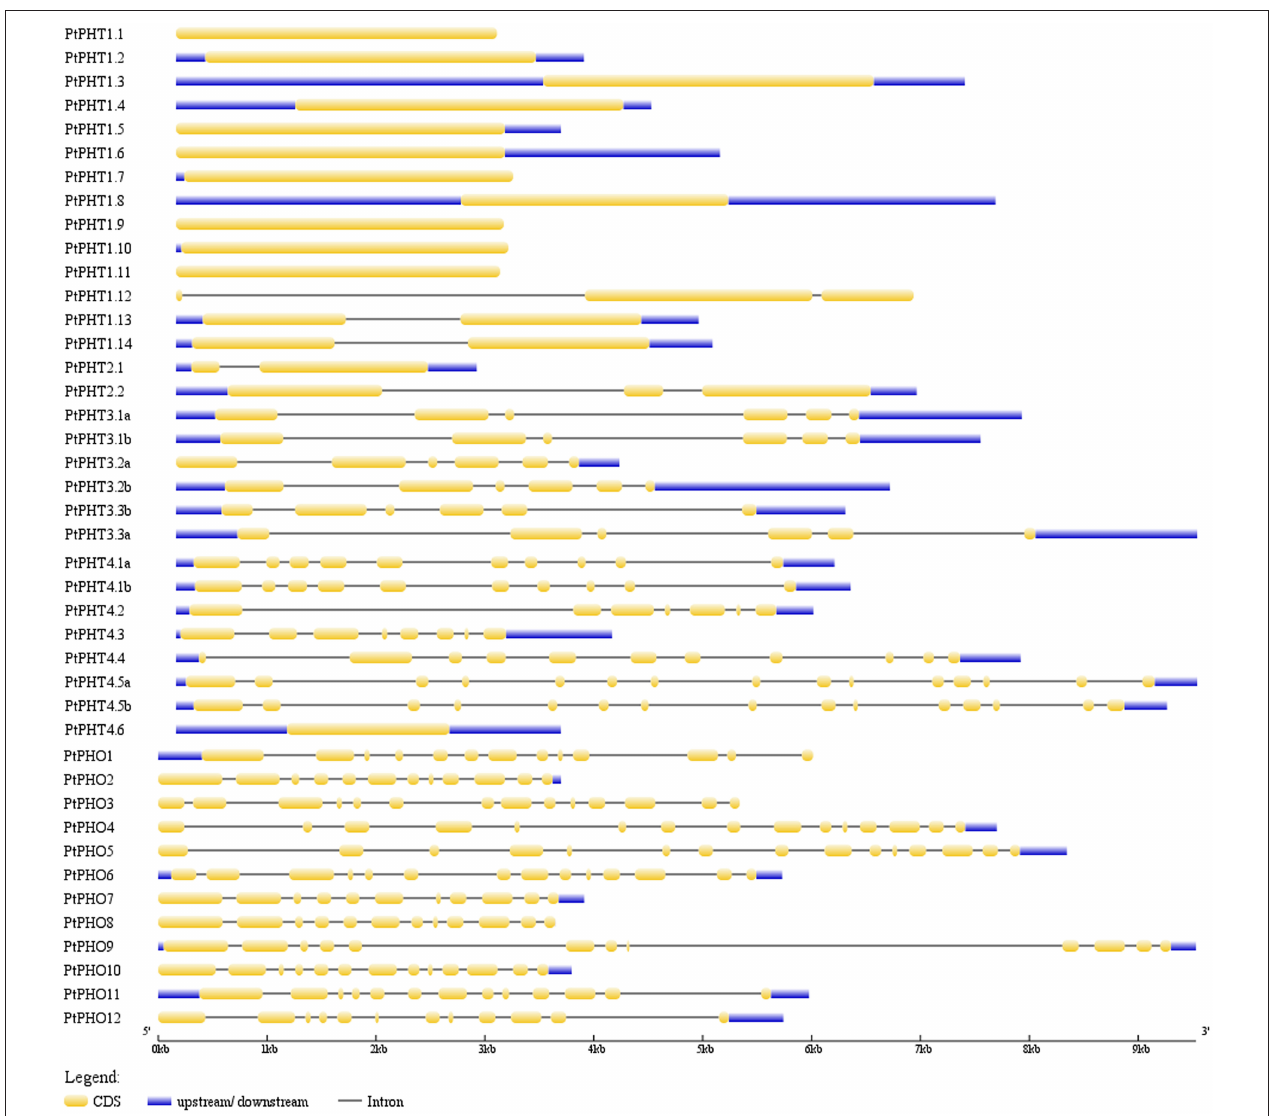
FIGURE 3 | Exon/intron structures of PHT genes in Populus . The exon/intron organization of the individual PHT gene was drawn using Gene Structure Display Server (GSDS) program (Hu et al.,